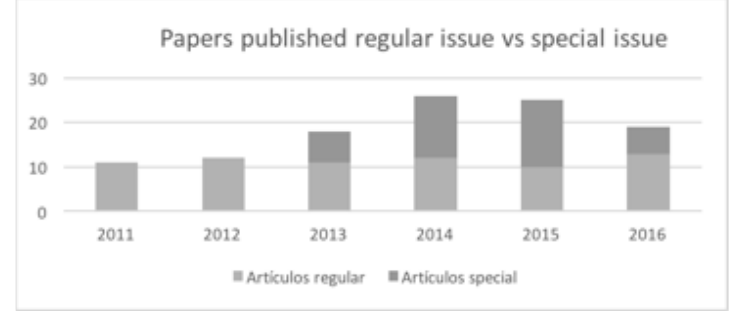
Figure 1. JOTSE's